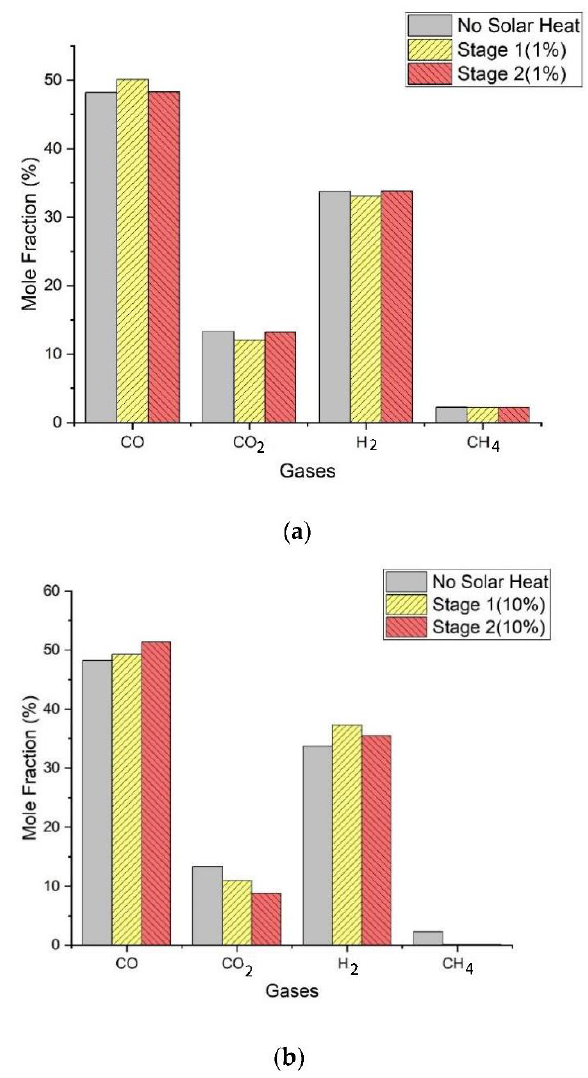
Figure 10. Mole fractions (% dry basis) for product gas yields for different oxidizer compositions.